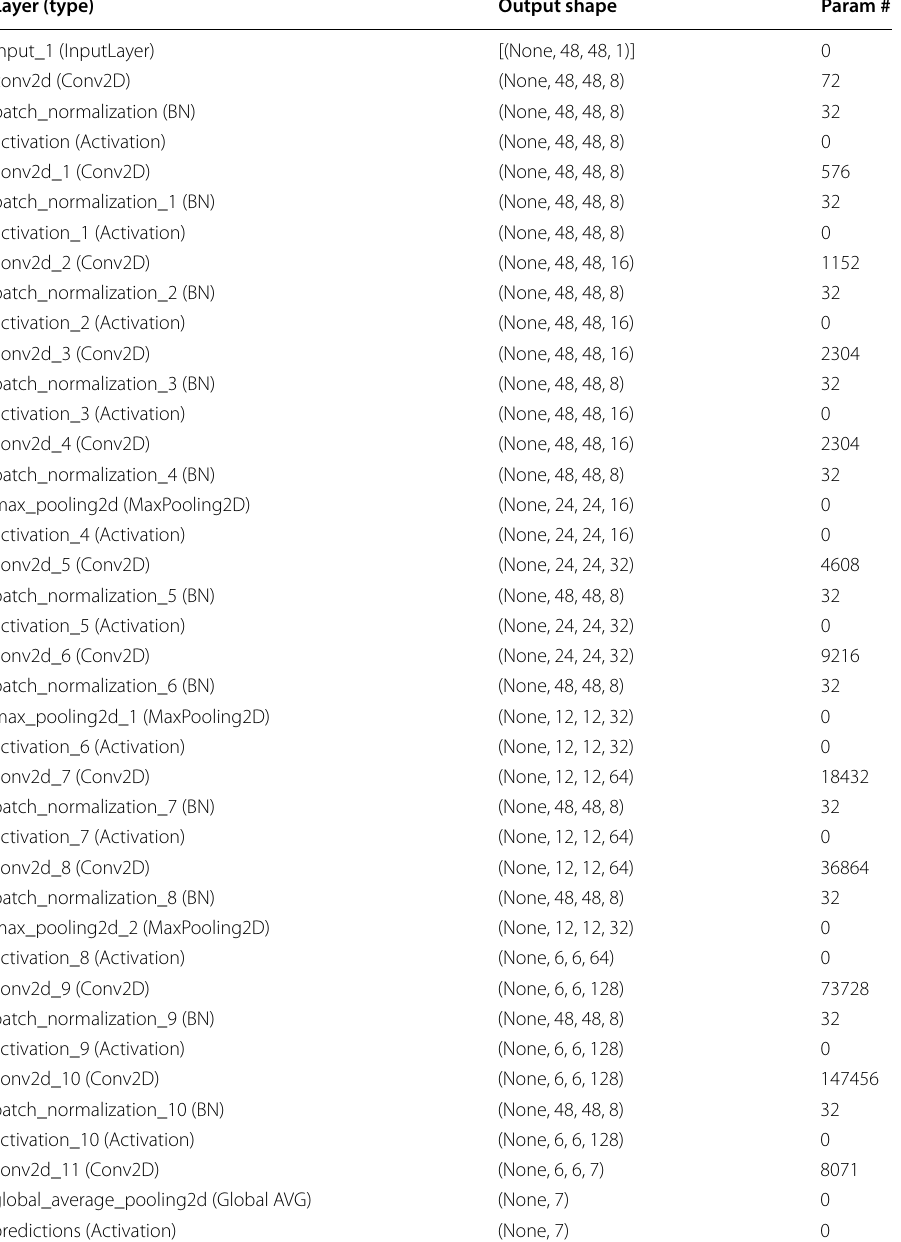
Table 3 Architecture with no-separable convolution, with AVG pooling